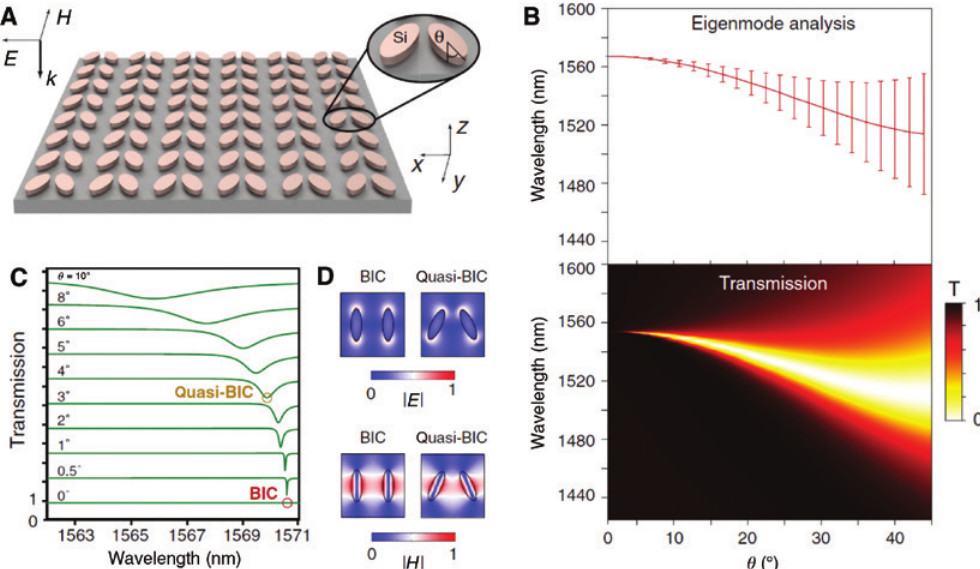
Figure 8: Quasi-BICs can be excited by symmetry distortions. (A) A square lattice of tilted silicon-bar pairs with a design of the unit cell. Parameters: period is 1320 nm, bar semiaxes are 330 and 110 nm, height is 200 nm, distance between bars is 660 nm. (B) Eigenmode spectra and transmission spectra with respect to pump wavelength and angle θ . Error bars show the magnitude of the mode inverse radiation lifetime. (C) Evolution of the transmission spectra versus angle θ . Spectra are relatively shifted by 1.5 units. (D) Distribution of the electric and magnetic fields for both BIC and quasi-BIC. Reprinted with permission from [48]. © Copyright 2018 American Physical